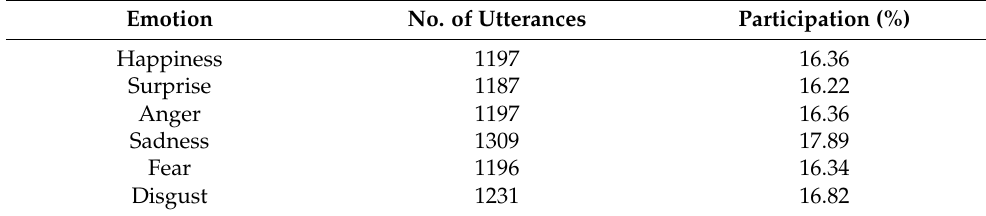
Emotion No. of Utterances